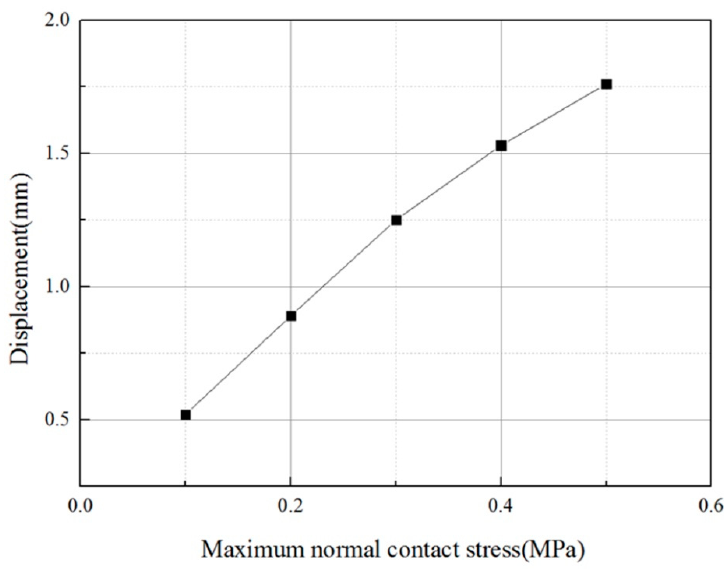
Figure 17. Variation curve of the horizontal displacement at the initial cracking of the interface with the maximum normal contact